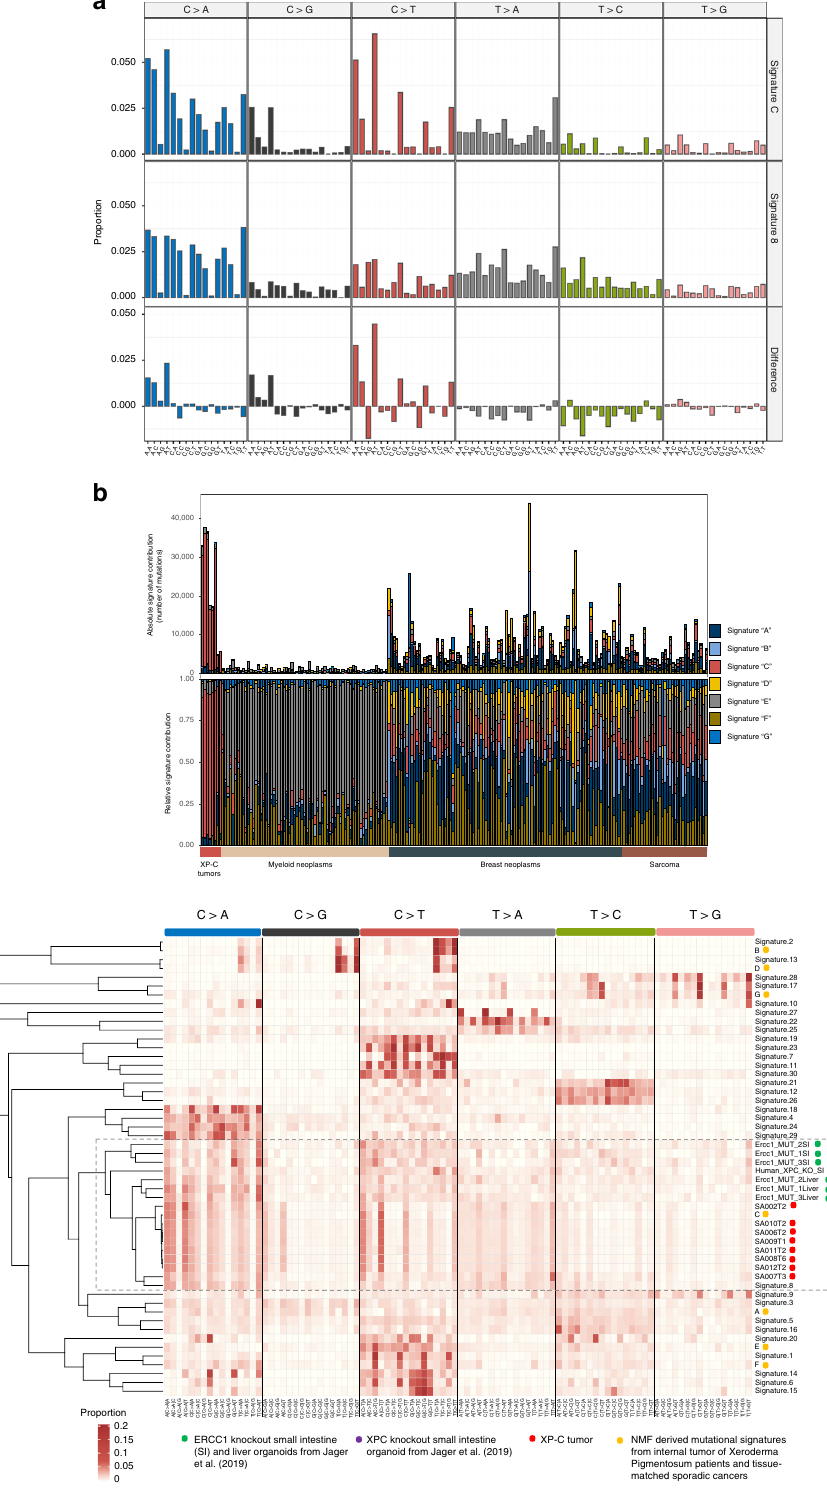
Fig. 2 Mutational pro fi les of XP-C tumors in the context of known mutational signatures. a NMF-derived mutational Signature “ C ” from XP-C tumors and tissue-matched sporadic cancers in comparison with COSMIC Signature 8 18 (Cosine similarity = 0.86). b Relative contribution of NMF-derived mutational signatures in XP-C and tissue-matched sporadic cancers (NMF approach). XP-C tumor mutational pro fi les are dominated by Signature “ C ” , while sporadic cancers by other signatures with relatively small proportion of Signature “ C ” . c Unsupervised hierarchical clustering based on the Cosine similarity distances between the XP-C tumors mutational pro fi les, NMF-derived mutational signatures from XPC tumors and tissue-matched sporadic cancers, COSMIC mutational signatures (Signatures 1 − 30), and XPC and Ercc1 organoid knockouts 19 . XP-C tumors cluster with each other and COSMIC Signature 8 forming a larger cluster with Ercc1 and XPC organoid